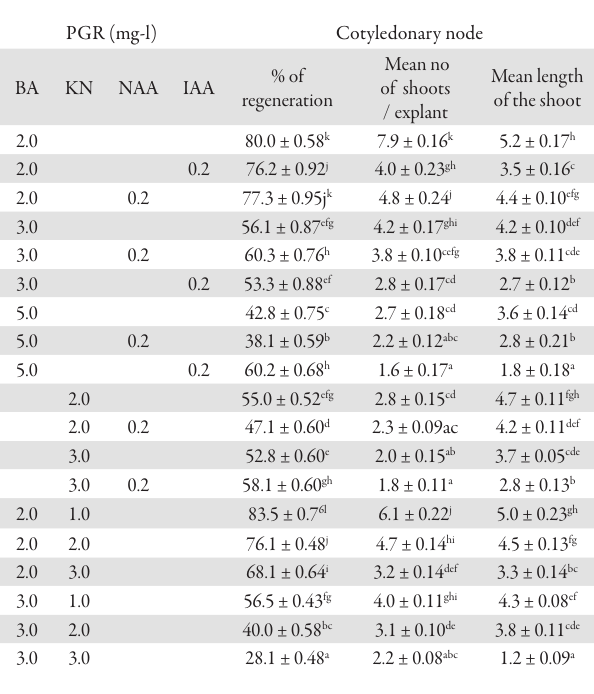
Fig. 2. Direct shoot regeneration from shoot tip of Soymida feb- rifuga ; (A) Single shoot initiation on MS medium supplemented with 2.0 mg l –1 BA after one week; Multiple shoot proliferation on the above medium after 2 weeks (B) 3 weeks (C) 4 weeks (D) 5 weeks (F); (G) Production of multiple shoots with basal callus on medium containing 2.0 mg l –1 BA + 0.2 mg l –1 NAA after 3 weeks; (H, I) Shoot elongation on medium containing 2.0 mg Tab. 2. Effect of plant growth regulators on shoot initiation from shoot tip seedling explants of Soymida febrifuga (after 8